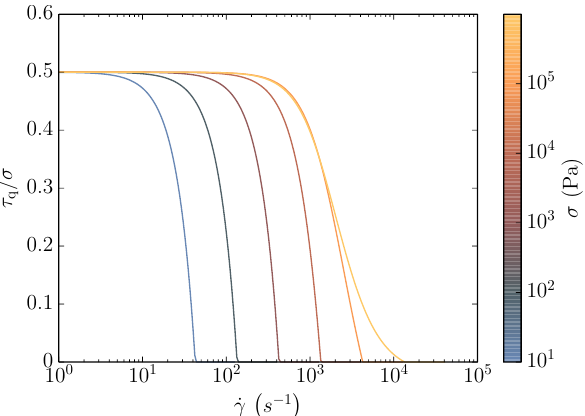
Figure 4. Stress ratio τ/σ in dependence of normal stress σ and shear rate ˙ γ .